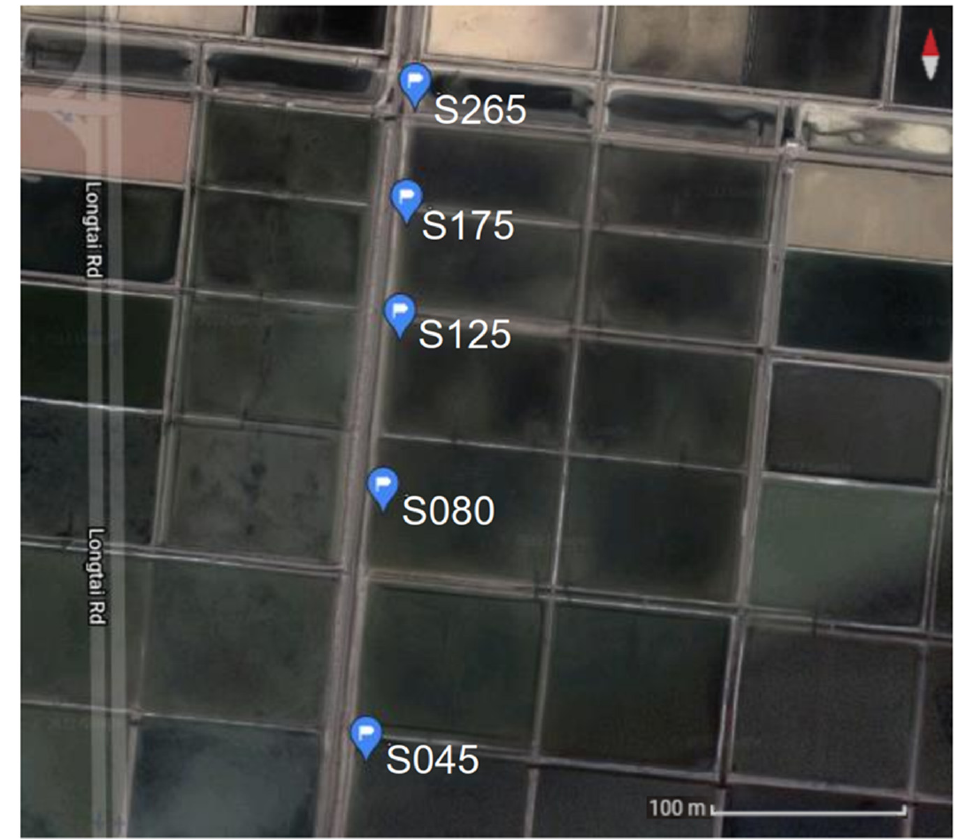
Figure 1. Overview of the Wendeng salterns. The salterns consist of a set of shallow ponds. The salinity of these shallow ponds is about 40, 80, 125, 175, and 265 g/L in sampling sites S045, S080, S125, S175, and S265, respectively.